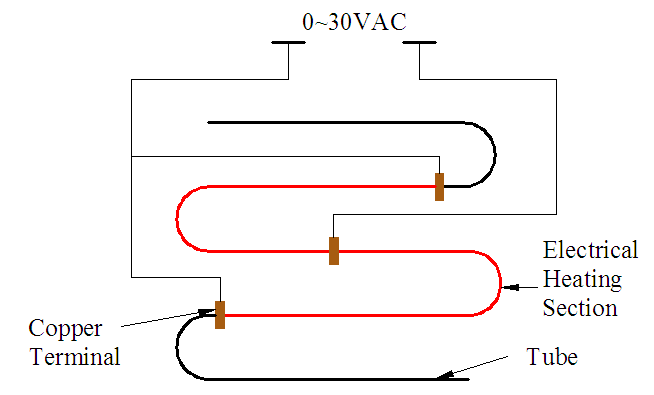
Figure 4. Electrical heating way for every heating